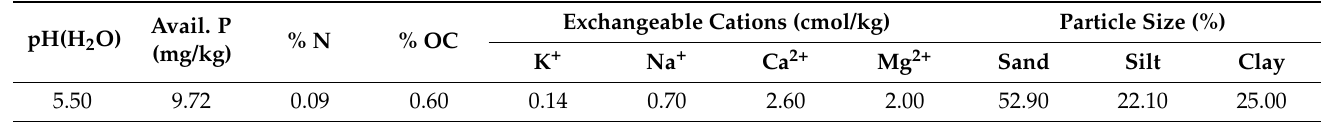
Table 6. Physical and chemical characteristics of soil at 0–20 cm depth before planting.